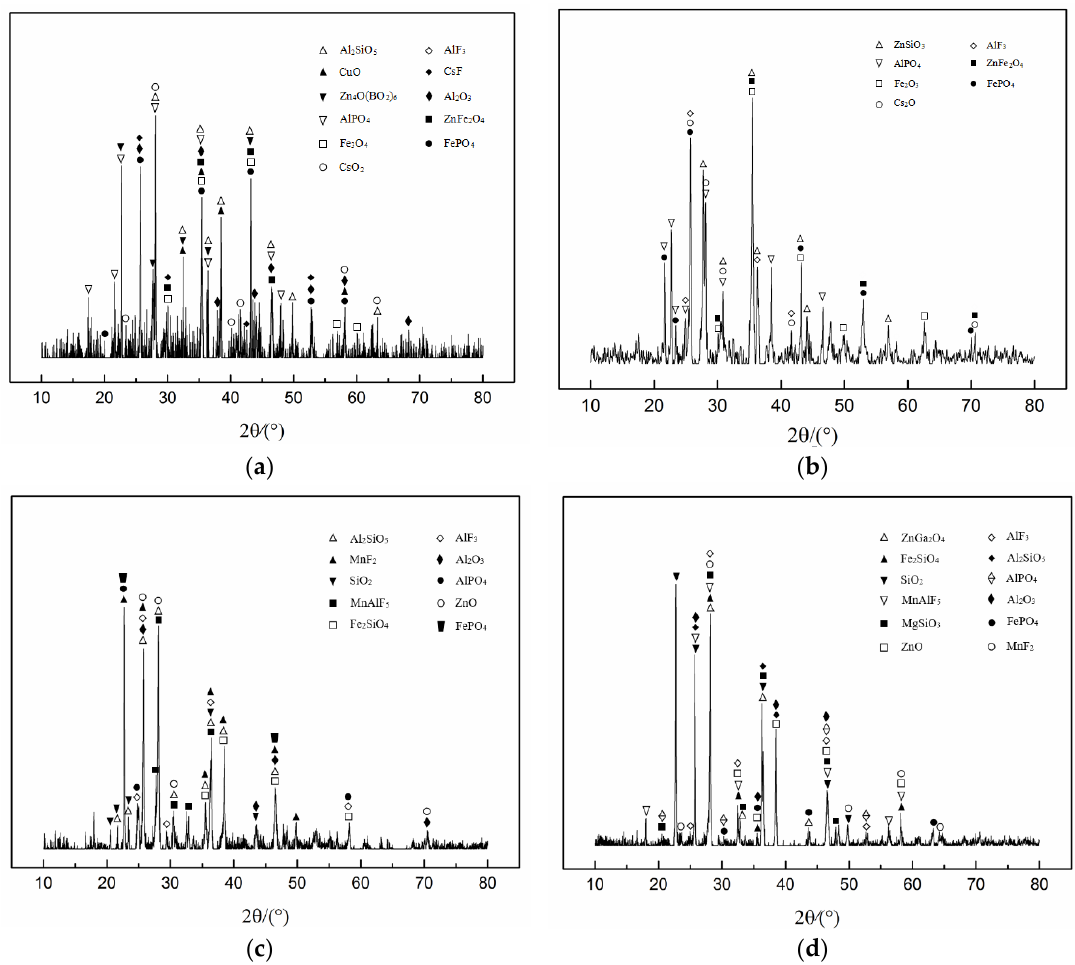
Figure 7. X-ray diffraction analysis results of the residues on Q235 low-carbon steel: ( a ) CsF-RbF-AlF 3 -Zn(BF 4 ) 2 ; (b) CsF-RbF-AlF 3 -ZnF 2 flux; ( c ) CsF-RbF-AlF 3 - Ga 2 O 3 flux; ( d ) CsF-RbF-AlF 3 -GaF 3 flux.